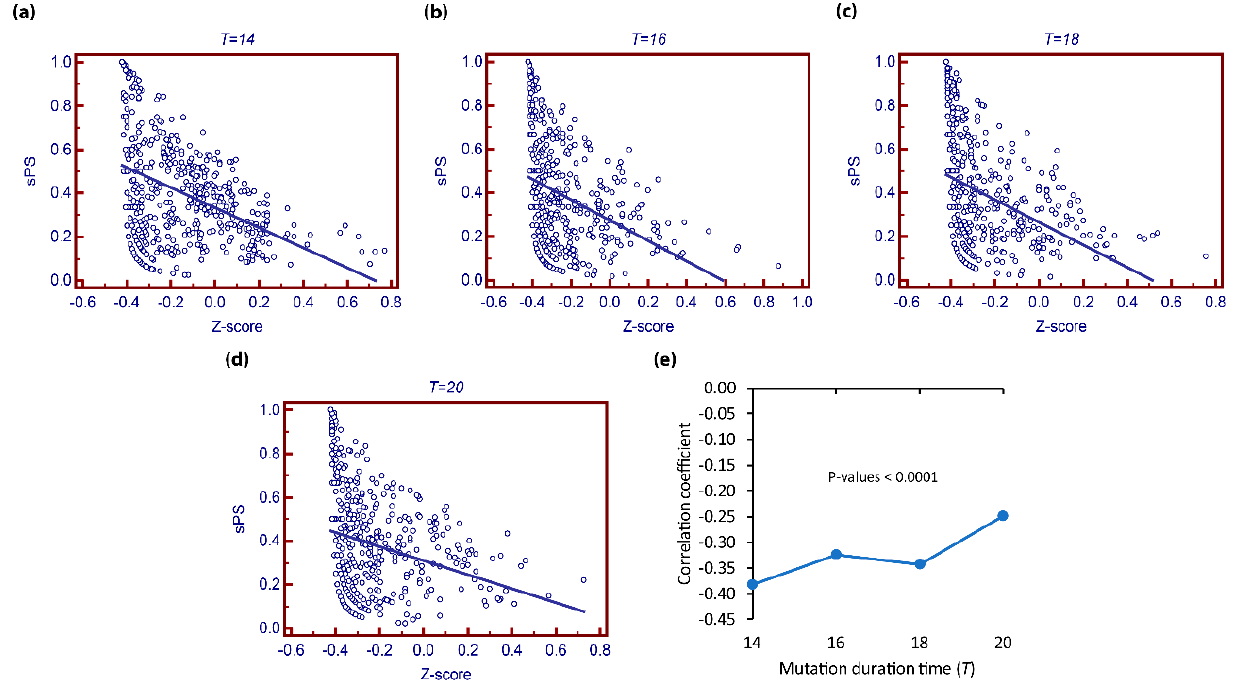
Figure 2. Relationship between sPS and zPS in KEGG network. ( a – d ) Relations of sPS and zPS in scatter-plot graph for mutation duration time T = 14 − 20, respectively. ( e ) Correlation coefficients of sPS and zPS . Only genes with positive sPS values were examined. All p -values are significant ( p -value < 0.0001).